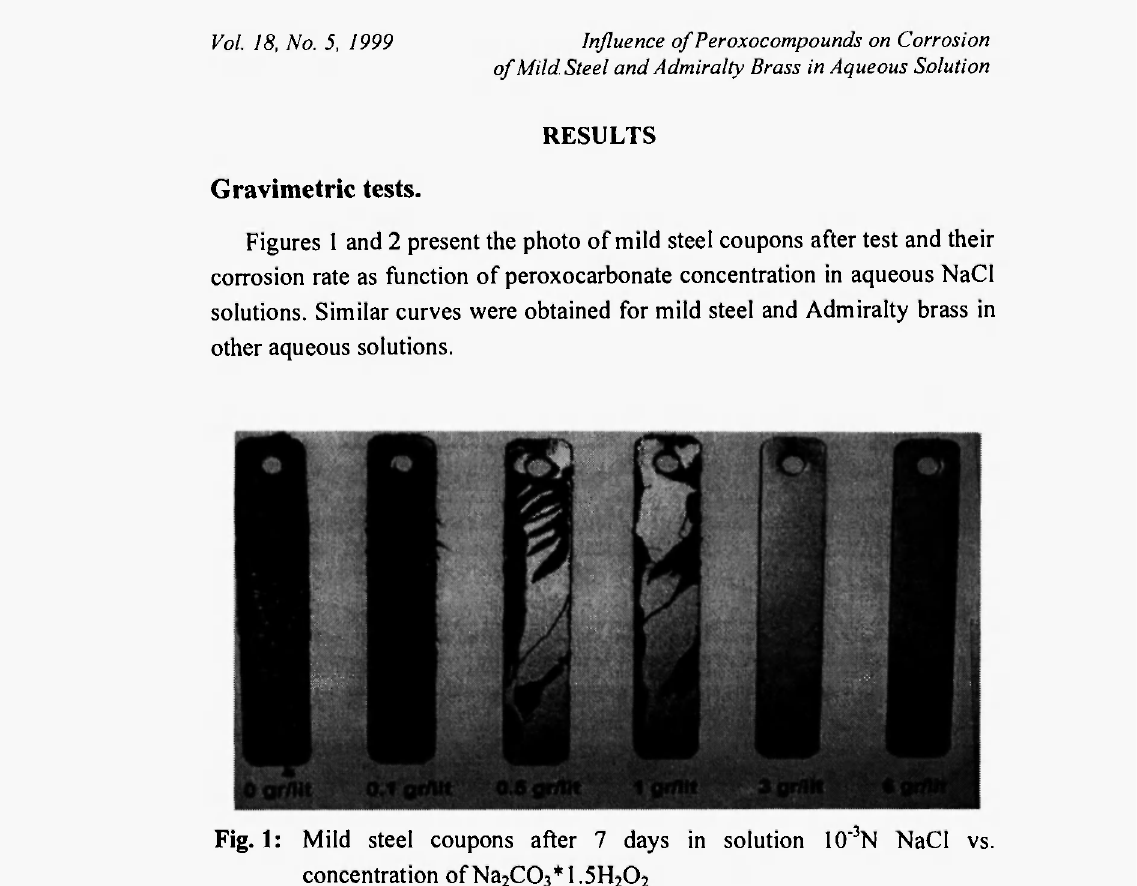
Fig. 1: Mild steel coupons after 7 days in solution 10" 3 N NaCl vs.